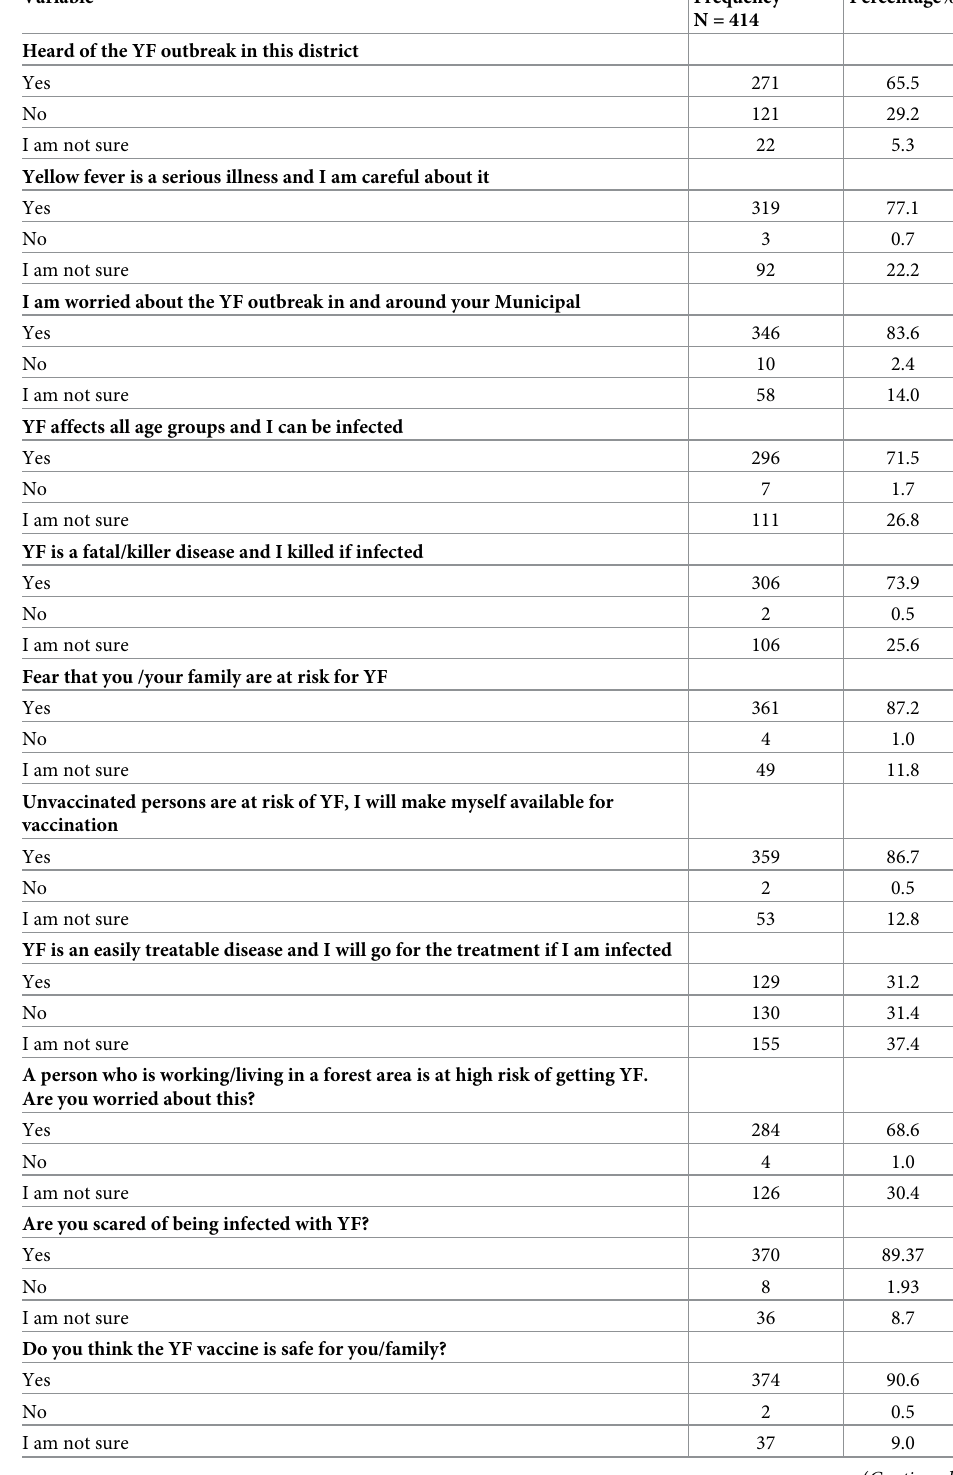
Table 3. Attitudes of nomadic populations in yellow fever outbreak communities in the West Gonja Municipal, Ghana,